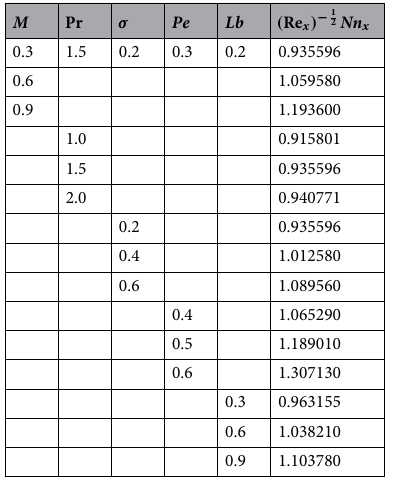
1 2 Nn x for various variations of M , Pr , σ , Pe and Lb